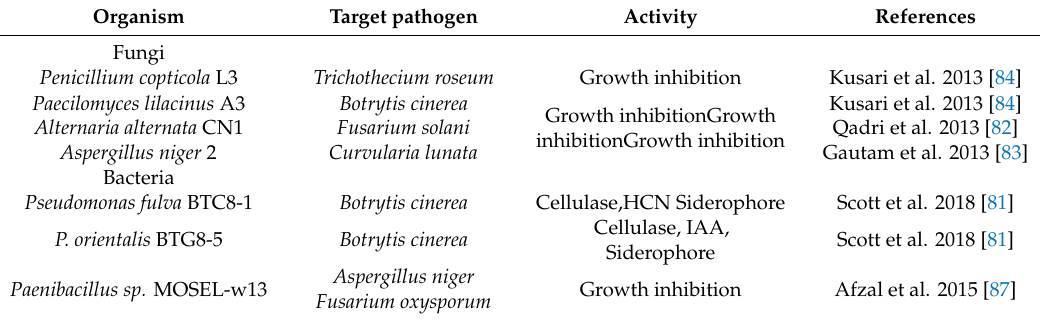
Table 2. Cannabis endophytes with antagonistic e ff ects against